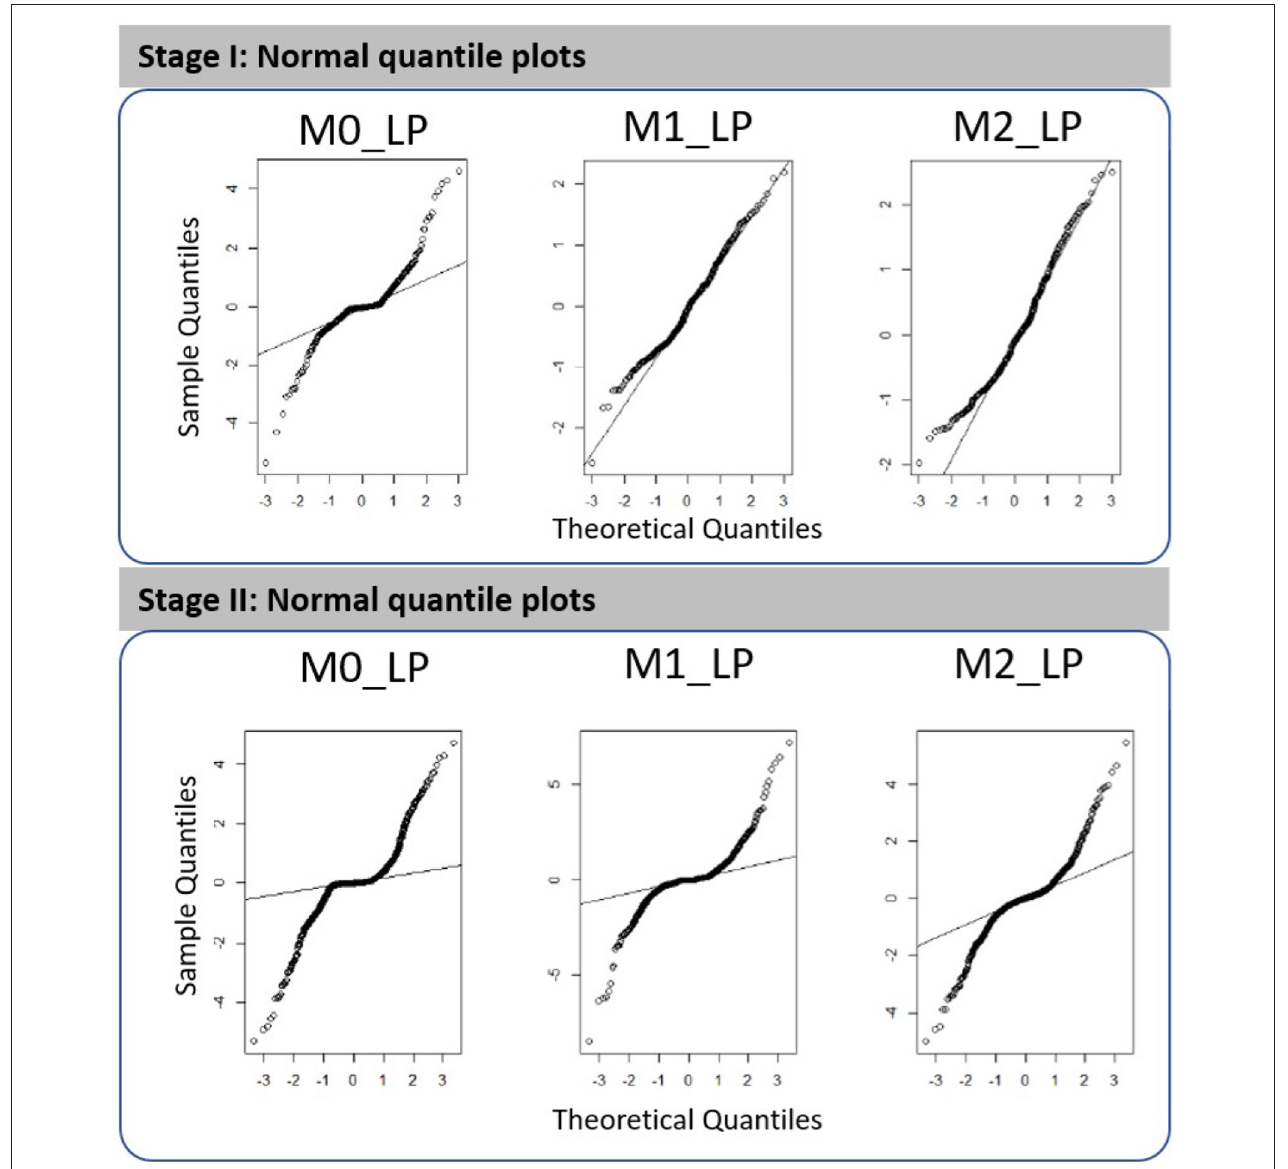
FIGURE 3 | Normal quantile plots obtained for the fitted metamodels with respect to outputs M0_LP, M1_LP, and M2_LP in the first stage analysis (three time periods, i.e., T 1 , T 2 , and T 3 ) and in the second stage high-resolution analysis (10 time segments in T 2